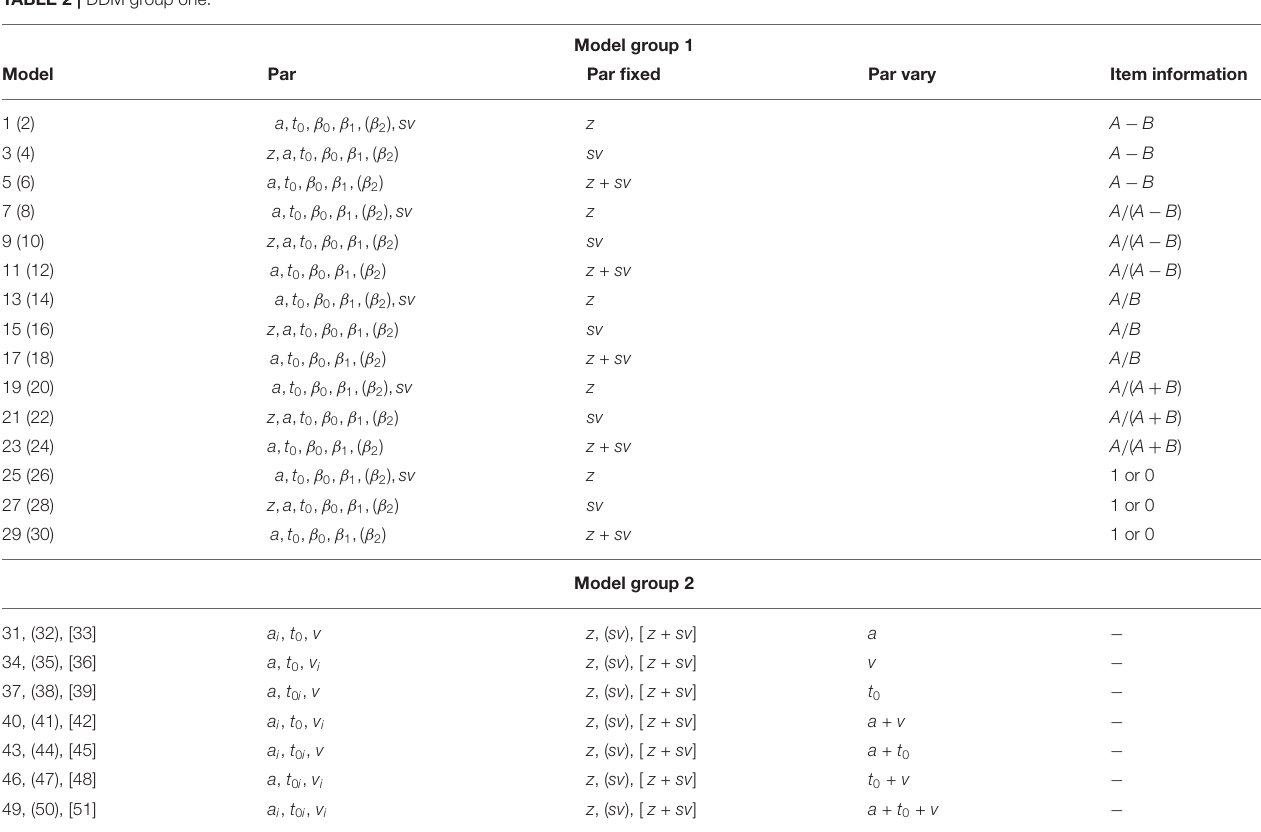
TABLE 2 | DDM group